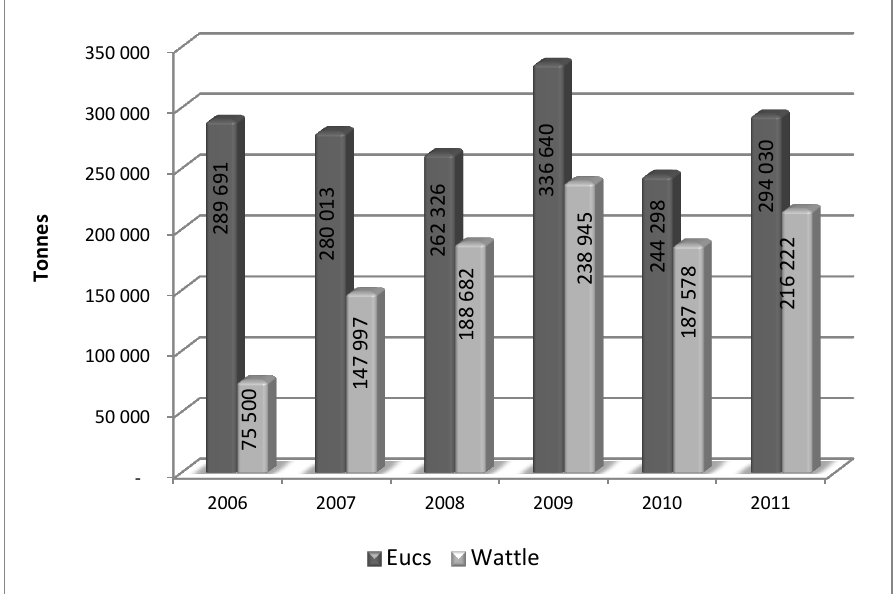
FIGURE 1: Annual wood chip exports from Durban per specie, 2006 to 2011